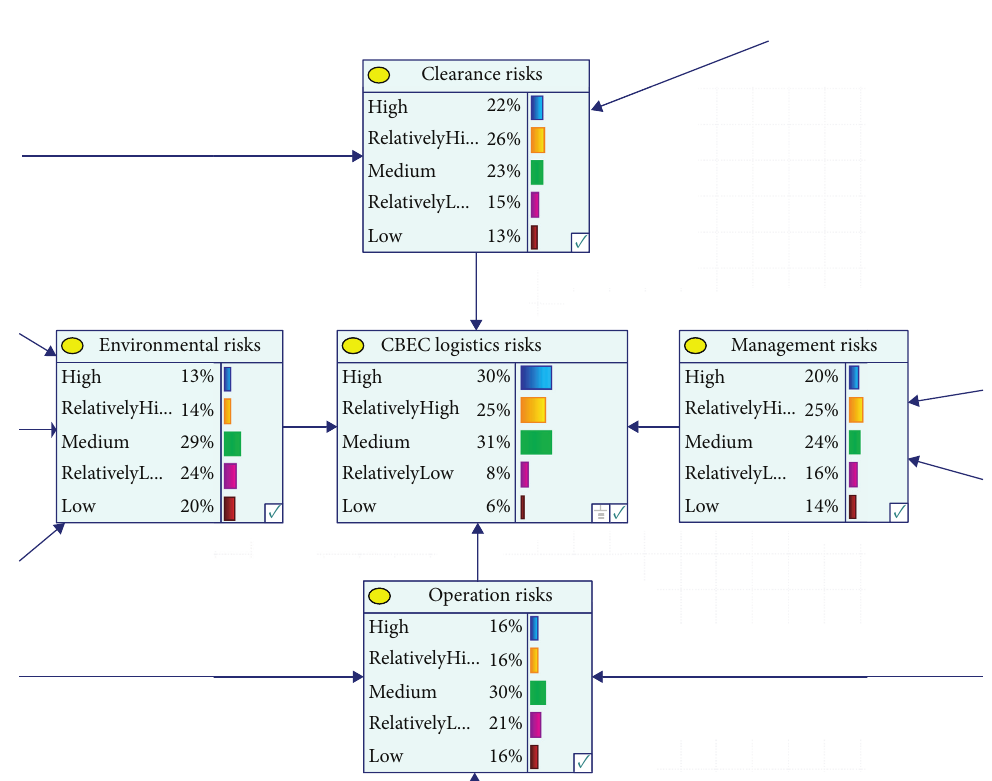
Figure 9: After logistics